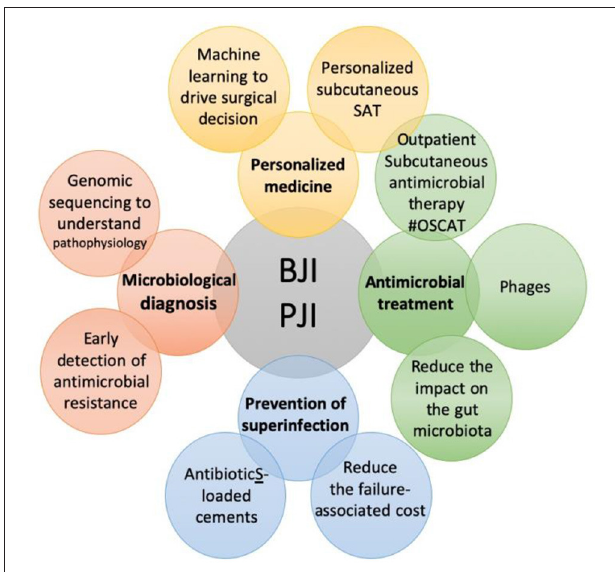
FIGURE 1 | The specific themes covered in the Research Topic “Innovative Approaches In The Management Of Bone and Joint Infection”.